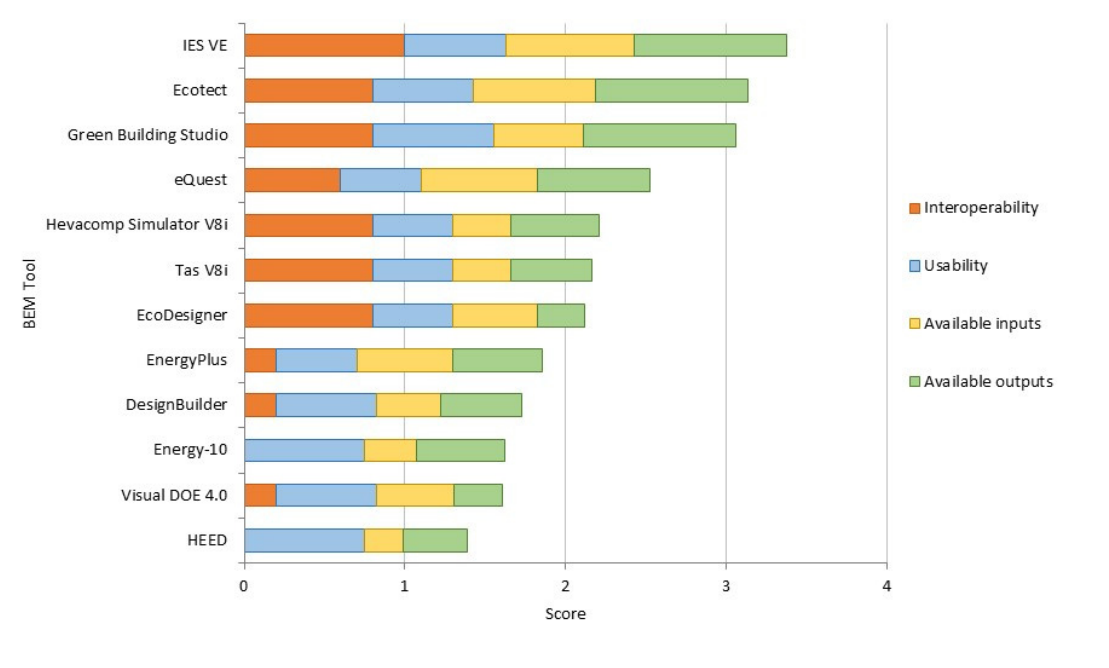
Figure 3. Initial evaluation